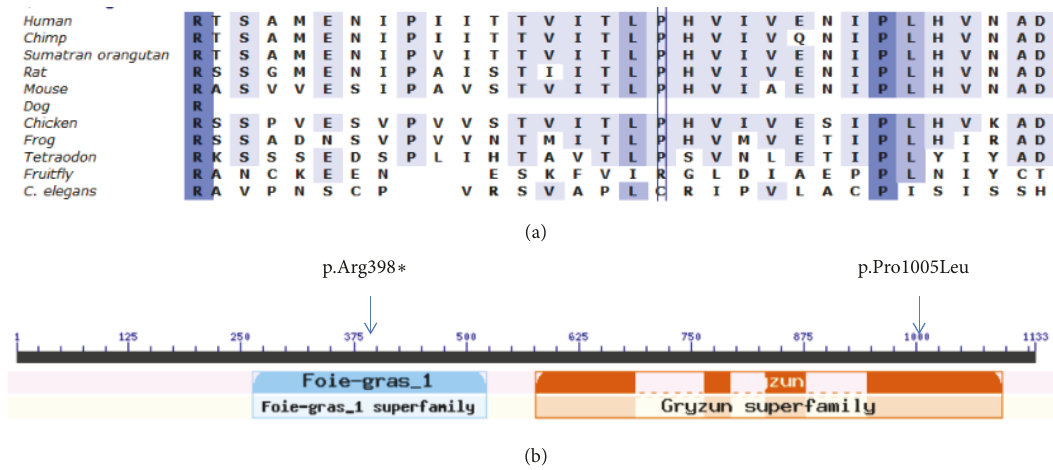
Figure 2: (a) Alignment of the c.1192C > T (p.Arg398 ∗ ) mutation across species, illustrating a conserved region. (b) Indication of both c.1192C > T (p.Arg398 ∗ ) and c.3014C > T (p.Pro1005Leu) mutations and their position in relation to functional domains of the